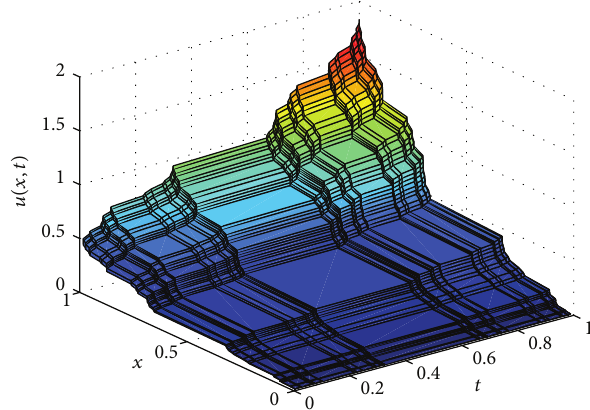
Figure 2: The plot of solution to local fractional Laplace equation with fractal dimension 𝛼 = ln 2/ ln 3